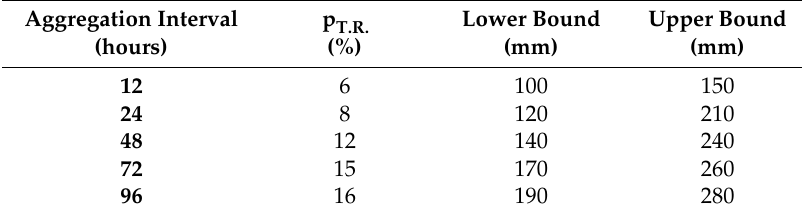
Table 5. The threshold values used in the current extreme rainfall detection